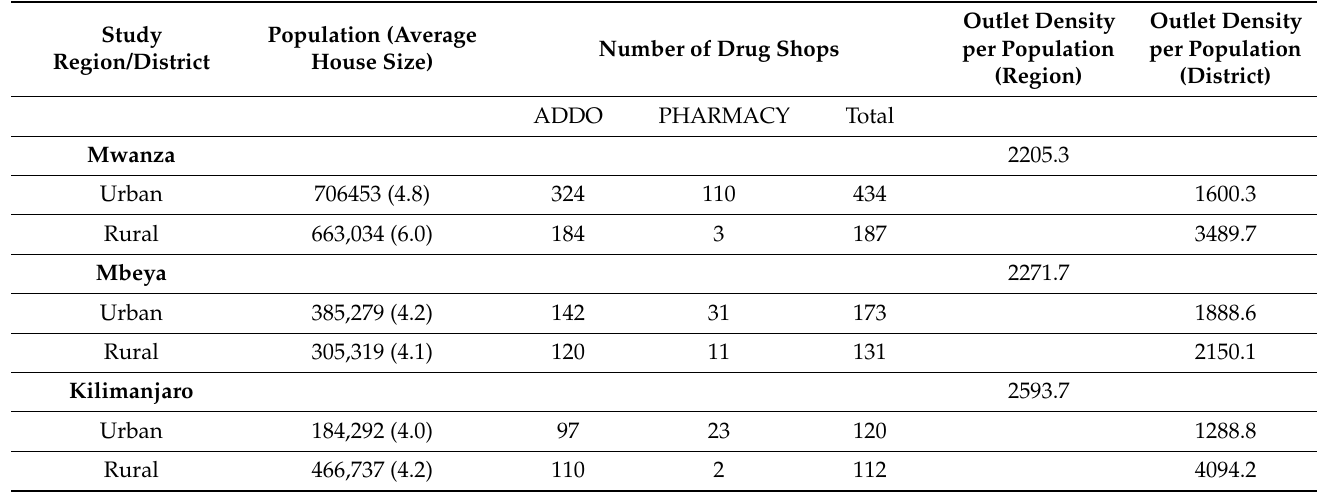
Table 1. Number of drug outlets and density per head of population by region and